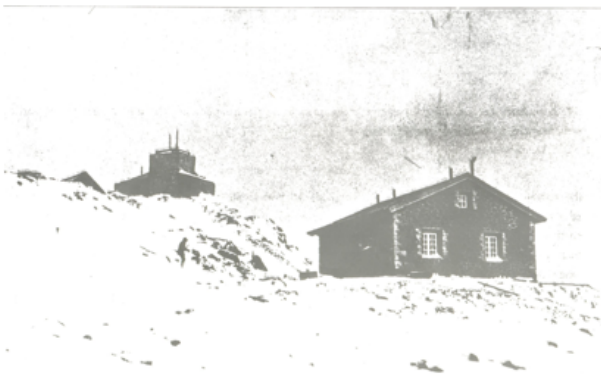
Figure 4. The observatory at Haldde in 1912 with “Borgen” in the back (Brekke,